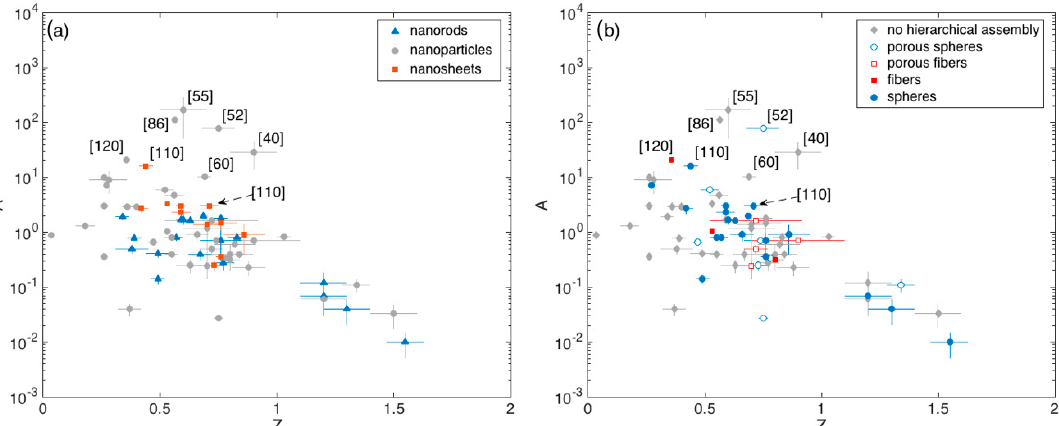
Figure 7. ( a ) Pre-exponential factor A of the calibration curve vs exponent Z extrapolated from fit with Equation (4), with ethanol concentration expressed in ppm. Dependence from crystallite morphology ( a ) and crystallite eventual hierarchical assembly ( b ). In some cases, error bars associated to the fitting parameters are smaller than the size of the respective data symbol.